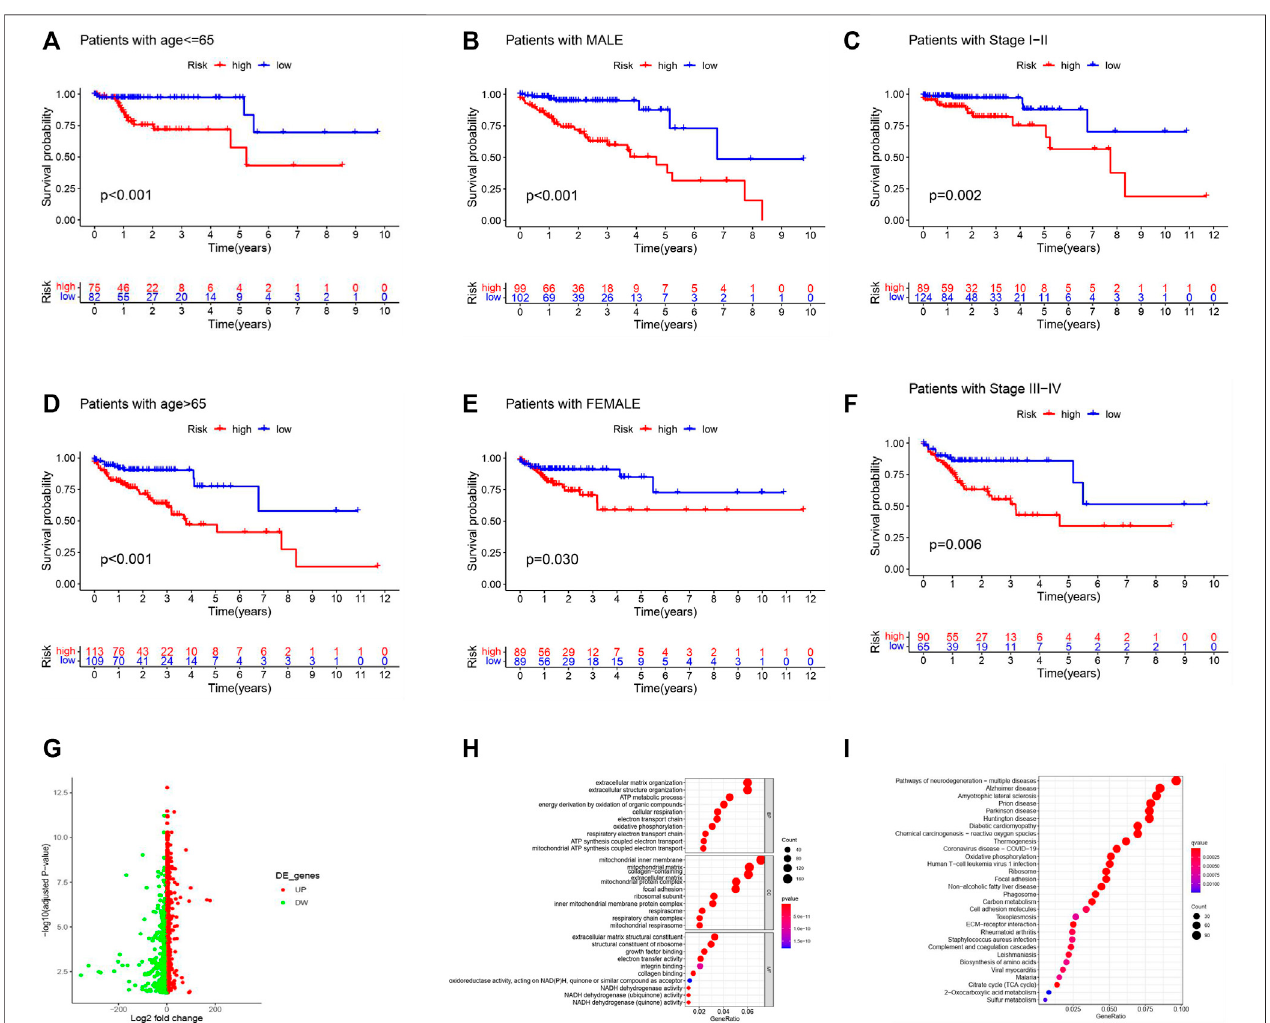
FIGURE 4 | Strati fi cation analysis and functional analysis. (A – F) Kaplan – Meier survival analysis showed that patients with high risk always had a worse OS when strati fi edbyage (A,D) ,sex (B,F) ,andstage (C,F) intheentiredataset. (G) VolcanoplotshowingtheDEGs. (H,I) GO (H) andKEGGpathway (I) analyses( p < 0.05)ofthe 2424 DEGs. The size of the circles indicates the gene count, and the color indicates the p value.